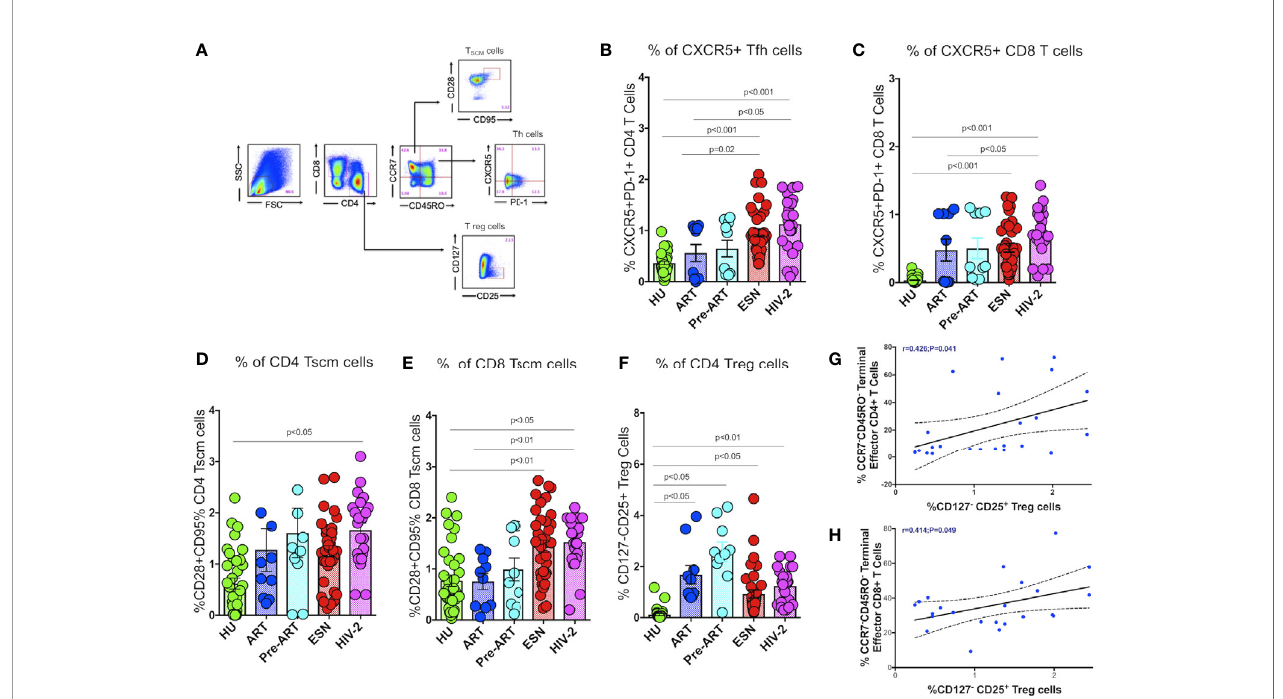
FIGURE 1 | Distribution of Tfh cells and stem-like memory T cells in the study population. (A) Representative fl ow plots for enumeration of Tfh cells, CXCR5 + T cells, Tscm cells and regulatory T cells. (B) Frequency of CXCR5 + CD4 + Tfh cells in the HU, HIV-1+ART+, HIV-1+ART-, HESN and HIV-2 groups. (C) Frequency of CXCR5 + CD8 + T cells in the HU, HIV-1+ART+, HIV-1+ART-, HESN and HIV-2 groups. (D) Frequency of CCR7-CD28+CD95+ stem-like memory CD4 + T cells in the HU, HIV-1+ART+, HIV-1+ART-, HESN and HIV-2 groups. (E) Cumulative frequency of CCR7-CD28+CD95+ stem-like memory CD8 + T cells in the HU, HIV-1+ART+, HIV-1+ART-, HESN and HIV-2 groups. (F) Frequency of CD127- CD25+ regulatory T cells in the HU, HIV-1+ART+, HIV-1+ART-, HESN and HIV-2 groups. Scatter dot plots summarize the % frequency of total CXCR5+ T cells, Tscm cells and Treg cells (median, 1st and 3rd quartiles). P values were calculated using the K-Wallis test. Sub-group analysis was performed using Dunn ’ s test. (G) Correlation between frequency of CCR7-CD45RO- Terminal Effector Memory CD4 + T cells and frequency of CD25+127- CD4 + T Regulatory cells in HIV-2 infected individuals. (H) Correlation between frequency of CCR7-CD45RO- Terminal Effector Memory CD8 + T cells and frequency of CD25+127- CD4 + T regulatory cells in HIV-2 infected individuals. (Note: HU: HIV unexposed seronegative controls, n = 35; HIV-1+ART+: HIV-1-infected women on ART, n = 10; HIV-1+ART-: HIV-infected women naïve to ART, n = 10; HESN: HIV exposed seronegative individuals, n = 35; HIV-2: HIV-2 infected persons, n =